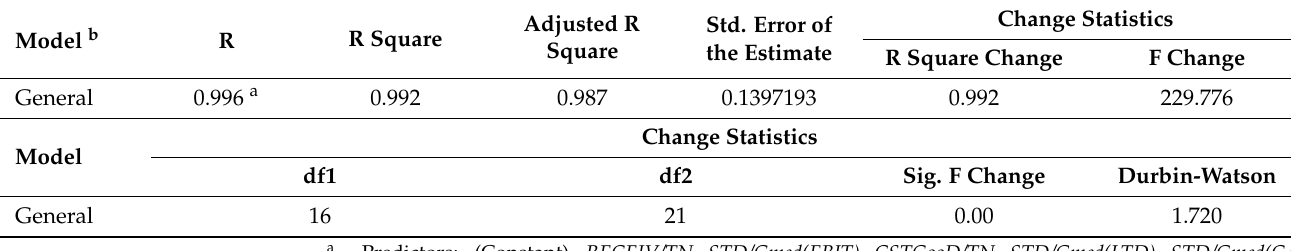
Table 1. Statistical summary of the general model.